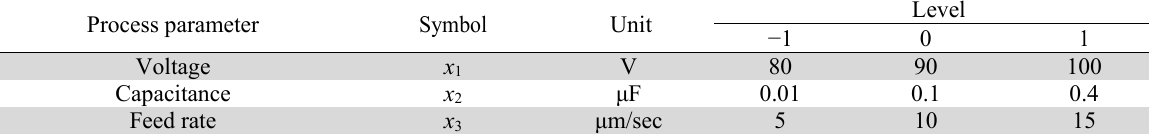
Micro-WEDM process parameters and their levels (Sivaprakasam et al., 2013) Process parameter Symbol